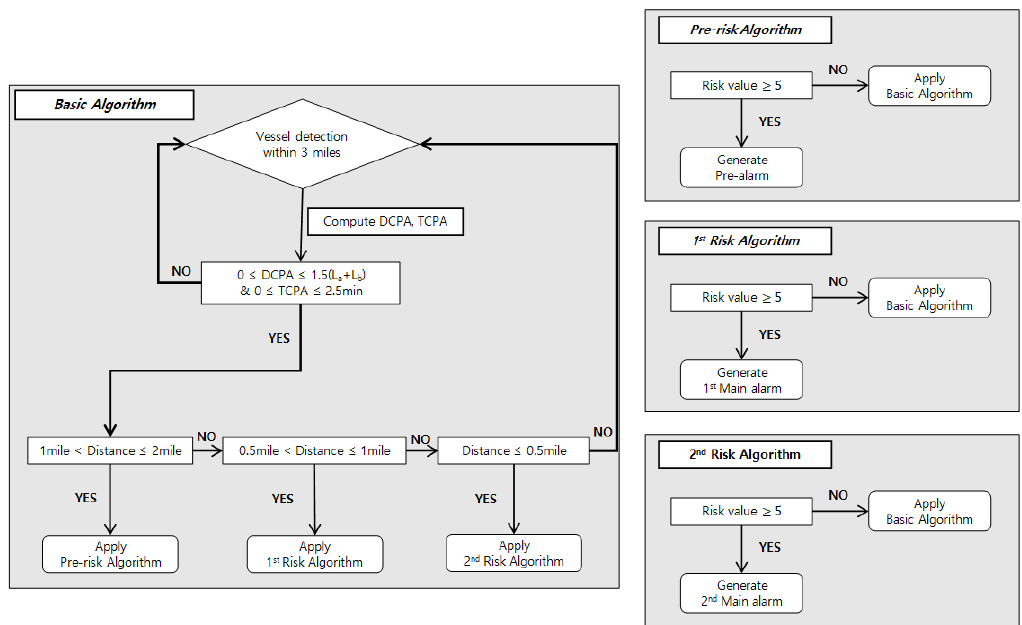
Figure 7. Flow chart of collision prevention algorithm for small fishing vessels.